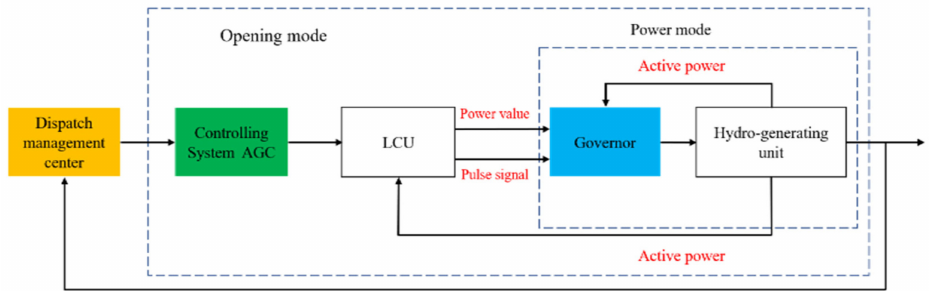
Figure 3. Grid-connected operation structure diagram of the hydro-turbine